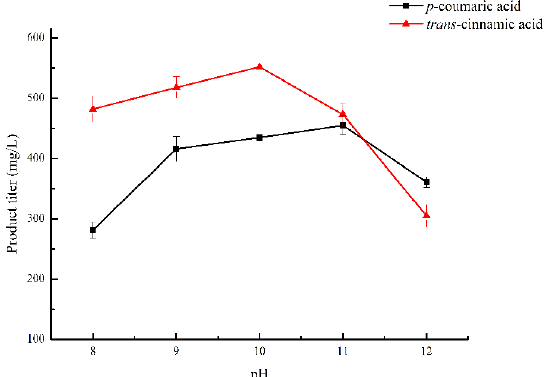
Figure 6. Effect of pH on conversion of L-Phe and L-Tyr to trans -cinnamic acid and p -coumaric acid by E. coli BL21(DE3)/pETDuet-1- RgPAL . Reaction conditions: Temperature: 42 °C; Medium: 20 mM Glycine-NaOH; L-Phe and L-Tyr 1 mg/mL; L-Phe conversion time: 24 h and L-Tyr conversion time: 20 h; Cell amounts: 6.67 g/L.